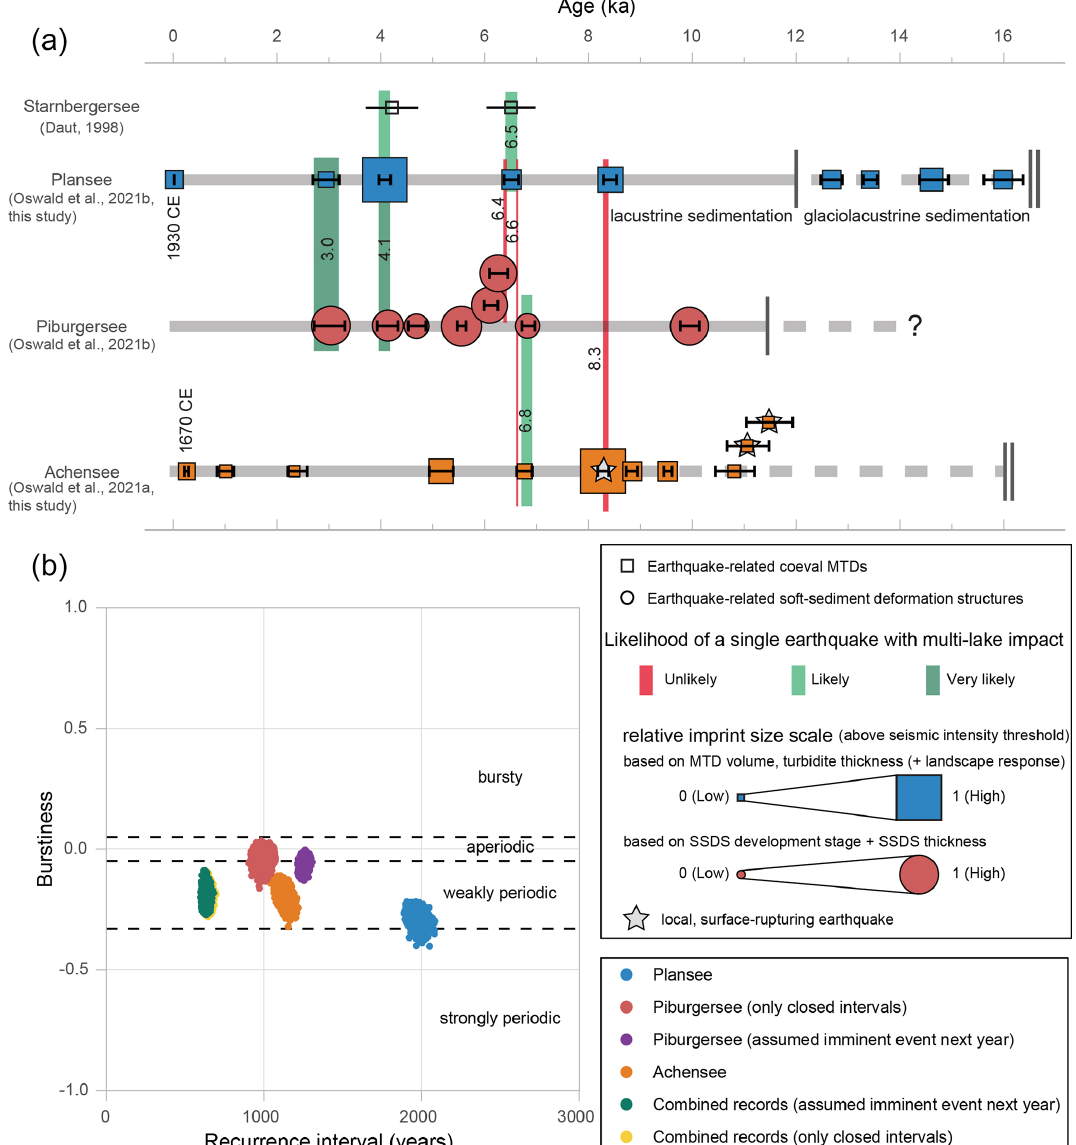
Figure 5. Lacustrine paleoseismic records of the western Austrian Alps, recurrence statistics of their paleo-earthquakes, and potential sin- gle earthquakes with impact on multiple lakes. (a) Timeline of the paleo-earthquakes at Plansee (this study and Oswald et al., 2021b), Piburgersee (Oswald et al., 2021b), and Achensee (this study and Oswald et al., 2021a) also including the potential earthquake-related mass-wasting events at Starnbergersee (Daut, 1998). Earthquake symbols are relatively scaled based on their imprint size above the EMS-98 intensity threshold for recording earthquakes at the lakes (cf. Oswald et al., 2021b). The likelihood assessment that these periods represent single earthquakes with an impact on multiple lakes (green–red color scale) is based on age overlaps of the individual event age PDFs (Fig. S3) and sedimentological evidence further described in the main text. Mean ages of age overlap are noted on the colored bars. Duration of lacustrine and glaciolacustrine sedimentation is indicated by continuous and dashed horizontal gray lines, respectively. (b) Recurrence interval–burstiness diagram of the three records calculated on all individual age–depth model simulations at the respective lake resulting in > 5400 data points for each record. The recurrence interval varies from ca. 1000 to 2000 years for the individual records and is ca. 680 years for all three records combined. The burstiness shows weakly periodic to aperiodic recurrence patterns for all data sets. Note that Piburgersee is considered as two data sets given the long open end since the last event: one data set where only the closed interevent times were considered and a second data set where an imminent event is assumed in the next